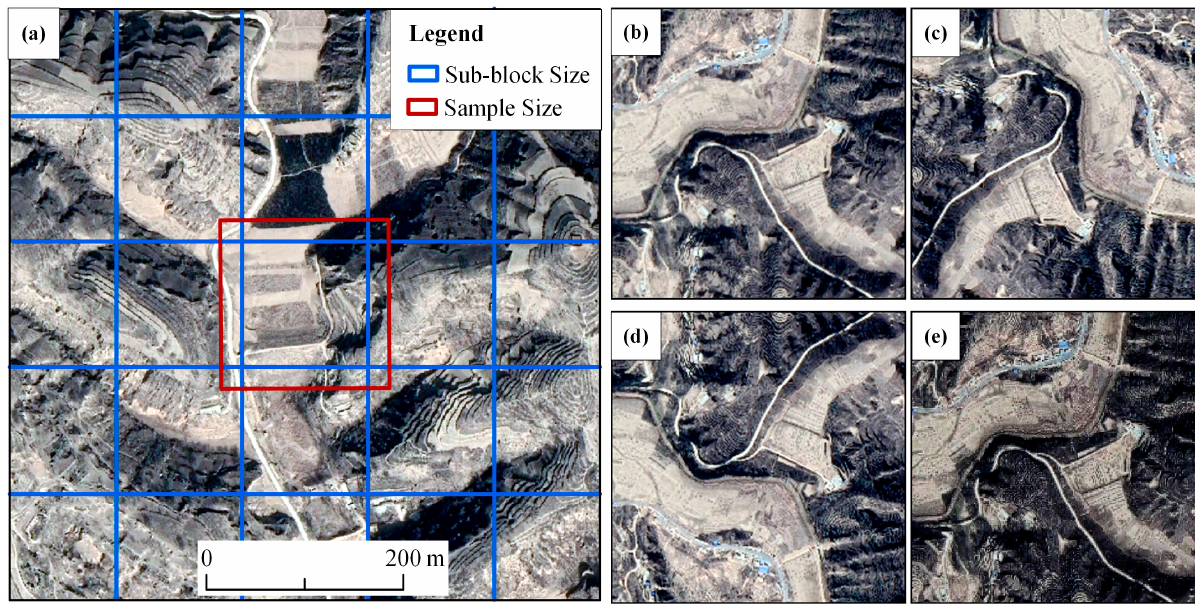
Figure 4. Sample size expansion and data augmentation. ( a ) The sample (red square) had a portion overlapping with its adjacent samples; ( b – e ) images of check dams after data augmentation; ( b ) original image; ( c ) rotation 90°; ( d ) horizontal flip; ( e ) sharpen.